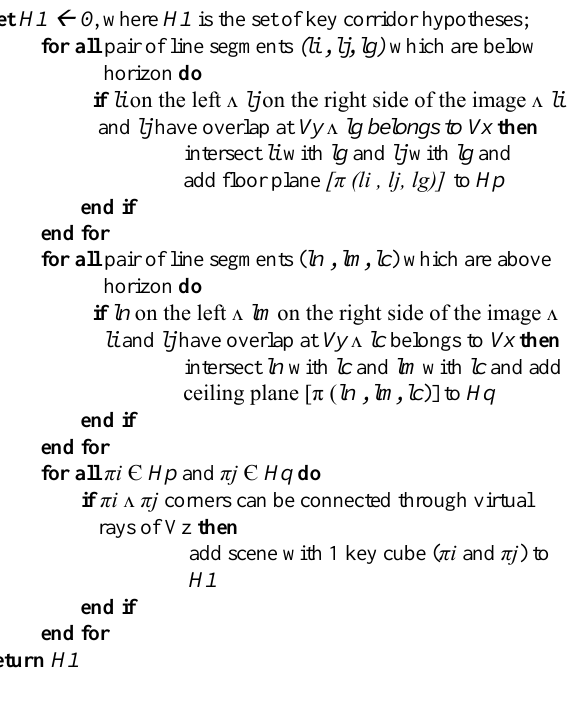
Algorithm 1: Generating key cube